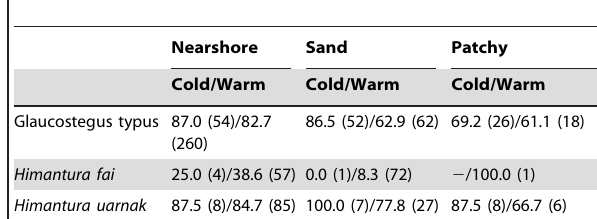
Table 3. Percentage (sample size) of resting giant shovelnose ray ( Glaucostegus typus ), reticulate whipray ( Himantura uarnak ), and pink whipray ( H. fai ) for each season and microhabitat.